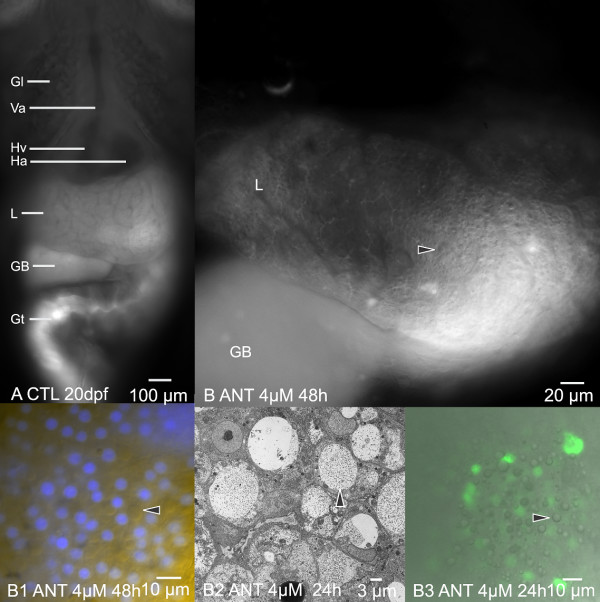
In vivo imaging of hepatobiliary toxicity: hydropic vacuolation. Acute exposures to 2 to 6 μM ANIT resulted in a marked "pebbling" phenotype. This terminology was adopted due to the morphological appearance of the liver (L), first observed in vivo with widefield fluorescence microscopy. (A) STII medaka control, 20 dpf, showing the normal smooth appearance of the hepatic parenchyma in vivo, as viewed with widefield fluorescence microscopy. (B) Widefield fluorescence microscopy, FITC image capture, STII medaka, 20 dpf. Shown is the "pebbled" appearance (black arrowhead) of the liver (L) in vivo; distinct at 2 μM to 6 μM aqueous ANIT. This phenotypic response was characterized (in vivo) by ovate structures within the cytosol of hepatocytes, which resulted in a pebbled appearance in the plane of focus in the liver. This phenotype was observed with the aid of autofluorescence alone, no fluorophores were necessary for visualizing this cellular response. (B1) ANIT exposed medaka exhibiting the pebbling phenotype were treated with the nuclear stain DAPI (aqueous bath) to label hepatocyte and biliary epithelial cell nuclei. After 1 hr of DAPI exposure the hepatobiliary systems of medaka were imaged in vivo via widefield fluorescence microscopy. These investigations found that intracellular ovate structures (black arrowhead) did not label with DAPI, and were distinguishable from hepatic and biliary epithelial nuclei (blue). (B2) Transmission electron micrograph showing cellular changes consistent with hydropic vacuolation, which was observed in both hepatocytes (black arrowhead) and bile preductular epithelia (not shown). Vacuoles ranged from 2 μm to 10 μm in diameter, and were found to be partially to completely filled with electron dense infiltrate. (B3) In vivo confocal image of YO-PRO-1, DIC and TRITC composite: nuclear labeling experiments performed with YO-PRO-1 revealed uptake of YO-PRO-1 into cells with putatively compromised cell membranes. In grayscale DIC image hydropic vacuoles (black arrowhead) are distinct. Associated with hydropic vacuolation was a slight increase in apoptosis (ovate green fluorescence, cell type not known). Of interest is the almost literal appearance of hydropic vacuoles in the confocal DIC fluorescence image (grayscale), where vacuoles appear as liquid droplets. Gill (Gl), Ventral Aorta (Va), Heart Atrium (Ha), Heart Ventricle (Hv), Liver (L), Gall Bladder (GB), Gut (Gt).